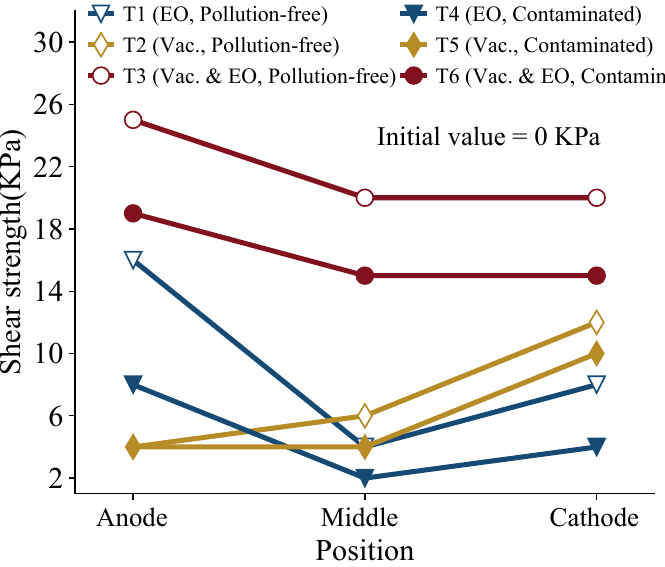
Figure 6. Vane shear strength of